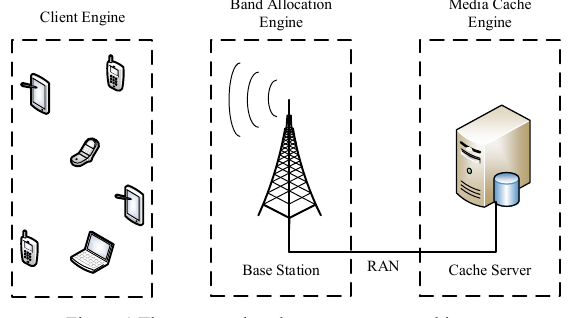
Figure.1 The proposed cache management architecture i.e. Media Cache Engine, Bandwidth Allocation Engine